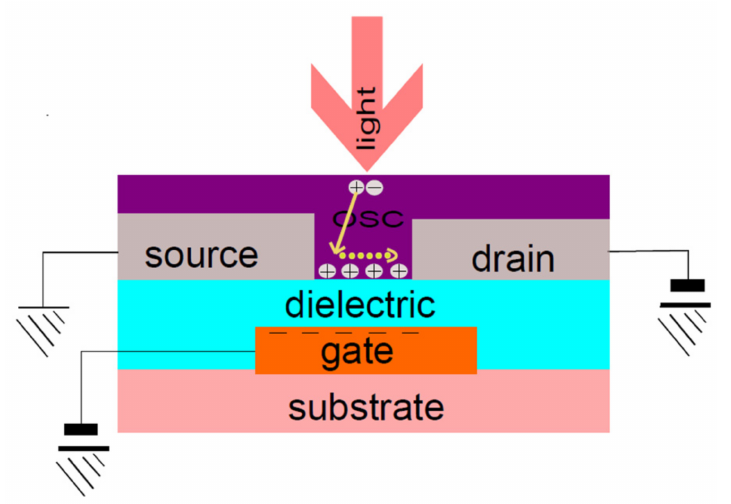
Figure 8. A typical p-type OPT device structure (TL). During illumination, positive charges drift towards the